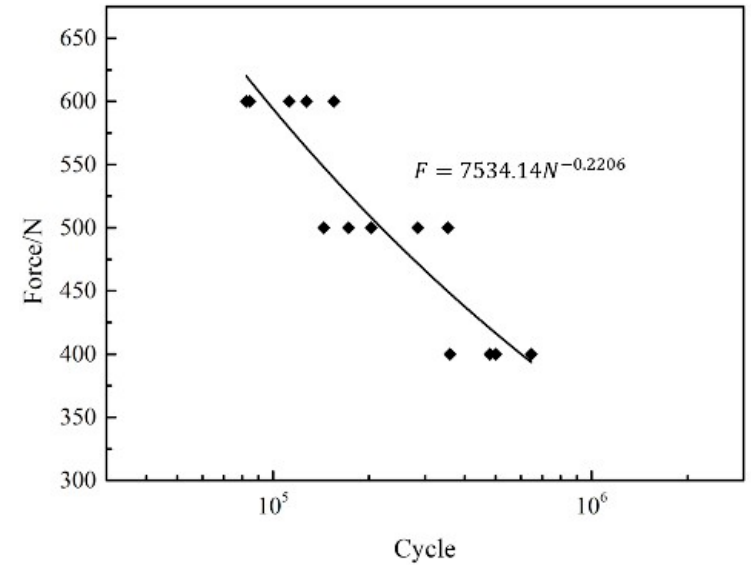
Figure 25. Fatigue life curve of rotor structure test specimens.